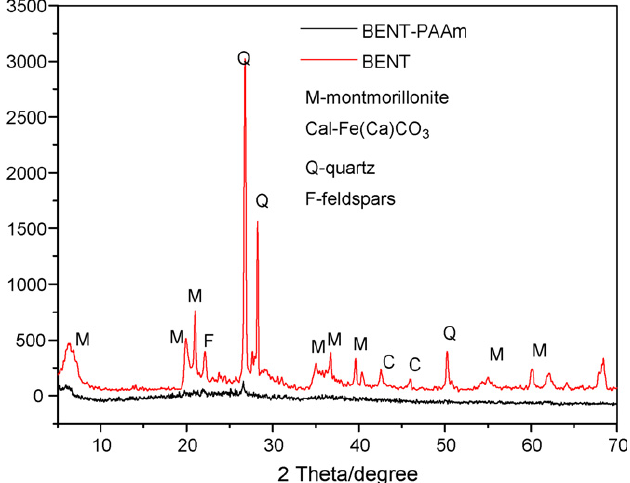
Figure 16. XRD patterns of Bentonite (BENT) and BENT–PAAm. Reprinted with permission from [223]. Copyright 2010